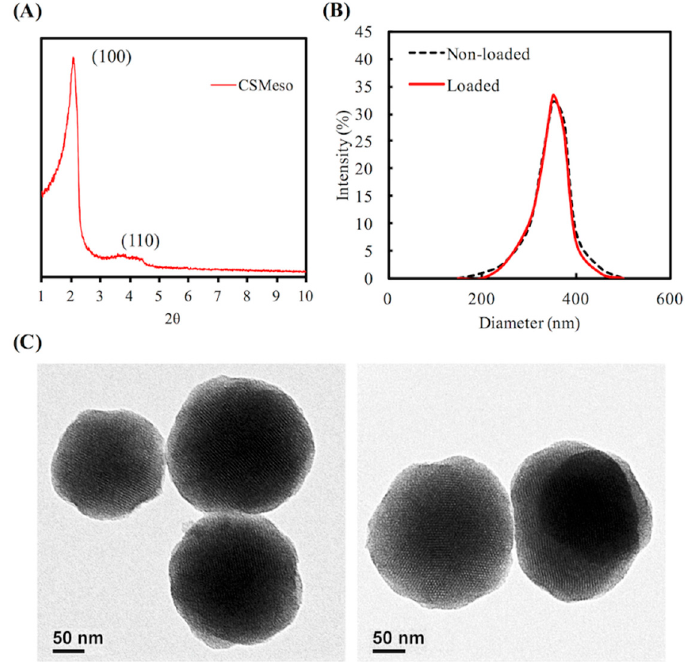
Figure 1. ( A ) Wide-angle XRD; ( B ) DLS; and ( C ) TEM analyses of MCS nanoparticles.